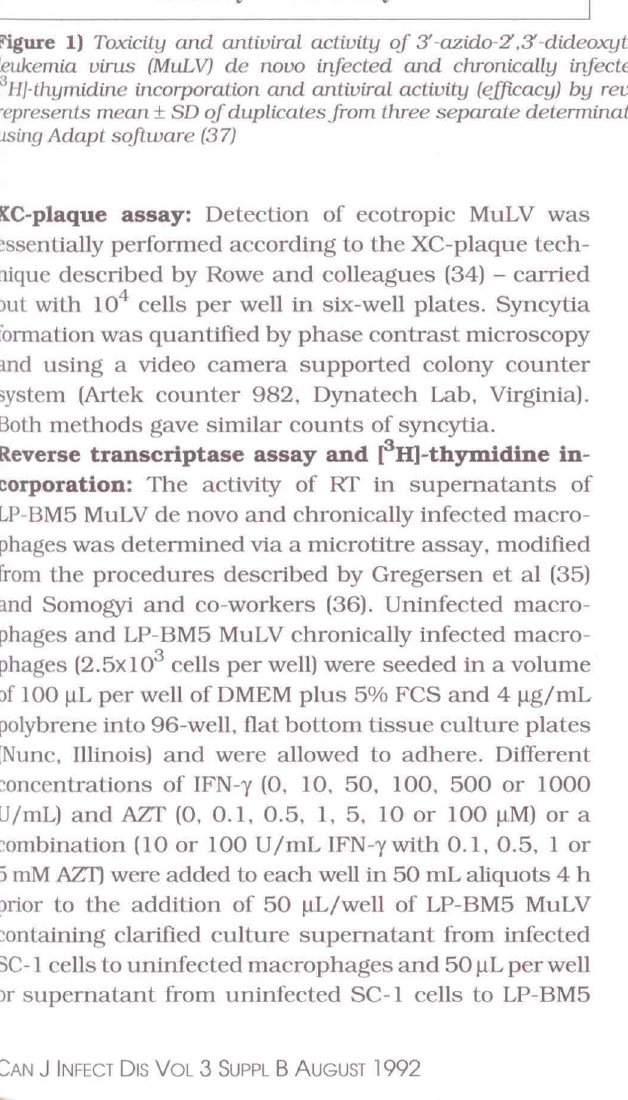
Figure 1) Toxicity and antiviraL activity of 3'-azido-Z.3'-dideoxythymidine (AZr) and interferon-gamma (IFN-"() in LP-BM5 murine leukemia virus (MuLV) de novo infected and chronically infected cultured murine macrophages. Toxicity was determined by FHJ-thymidine incorporation and antiviral activity (elficacy) by reverse transcriptase assay for AZr {A) and IFN-"( {B). Each symbol represents mean± SD of duplicates from three separate determinations. Curves were obtained by jitLing the data to the Hill equation using Adapt software (37)